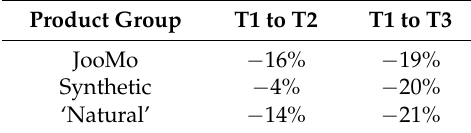
Figure 14. Corneometer (moisture) averages at each time point. Table 6. Average percentage change in moisture on the skin for all product groups.